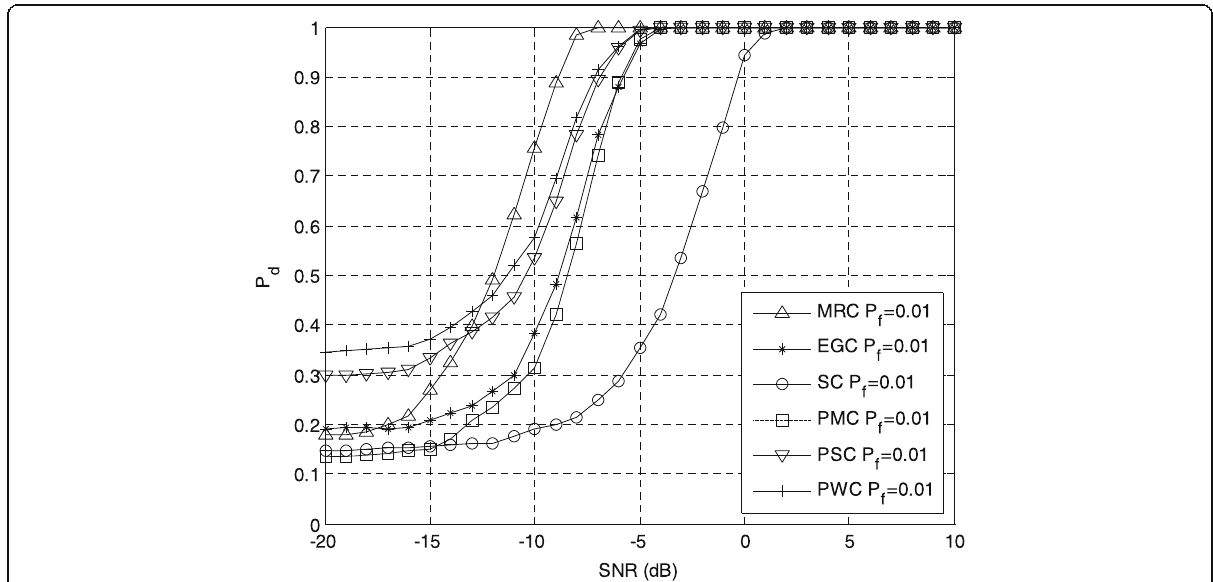
Fig. 11 Performance comparison of the pre-combining detection algorithm and proposed combining algorithm when P f =